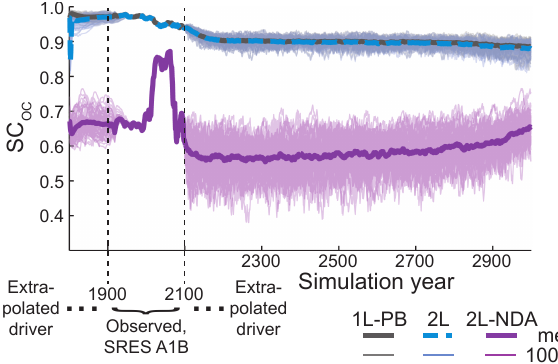
Figure 6. Temporal development of SC OC comparing the biomass of Ostrya carpinifolia in simulations of application scenario A2. Depicted SC OC values stem from comparisons of 1L-ORG simu- lations to two-layer simulations with and without dynamic associa- tions (2L and 2L-NDA, respectively) and simulations on one layer but with the bioclimate of the associated bioclimate types (1L-PB). Bioclimate types were derived with the set of bioclimate bins with moderate resolution (E2; for other bioclimate types see Supplement Sect. S3). For each setting 100 repetitions were compared, which were simulated using different pseudo-random number streams to extrapolate the bioclimate driver before 1901 and after 2100. Single simulations and their means are printed half-transparent and bold, respectively. Comparable to SC spec values (Fig. 5), SC OC values of comparisons between 1L-ORG and 2L simulations are very close to SC OC values from comparisons with 1L-PB simulations over the whole simulated time span. These SC OC time series thus reflect dif- ferences due to the averaging of the bioclimate driver. SC OC values from comparisons of 1L-ORG simulations with 2L-NDA simula- tions, in contrast, mainly reflect the reaction of O. carpinifolia to climatic changes on the whole simulation area (see Supplement Sect. S3.2), since 2L-NDA simulations were conducted without dynamic associations. 2L-NDA simulations get closer to 1L-ORG simulations towards the end of the simulation due to the northwards spread of O. carpinifolia in 1L-ORG over